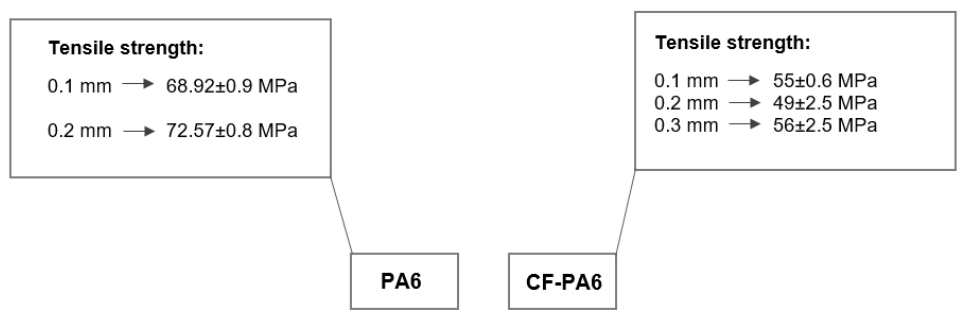
Figure 6. Obtained tensile strength values concerning the layer height effect investigation .